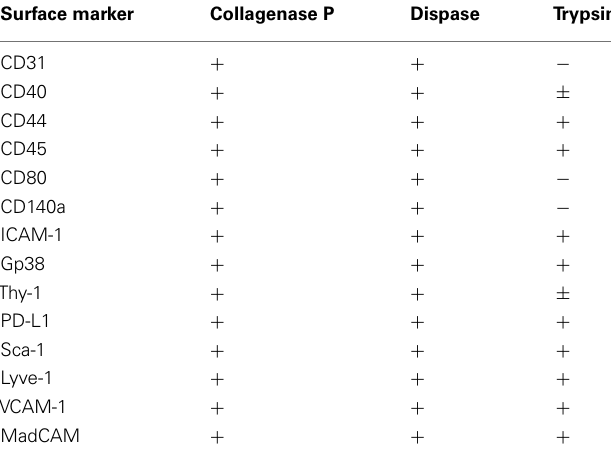
Table 2 | Enzyme sensitivity of surface markers used to characterize non-hematopoietic lymph node stromal